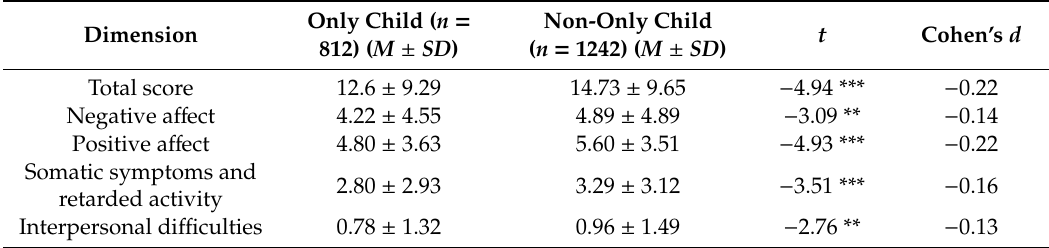
Table 2. Test of the di ff erence in the total score and dimensions of depression between only children and non-only children in the early adolescence